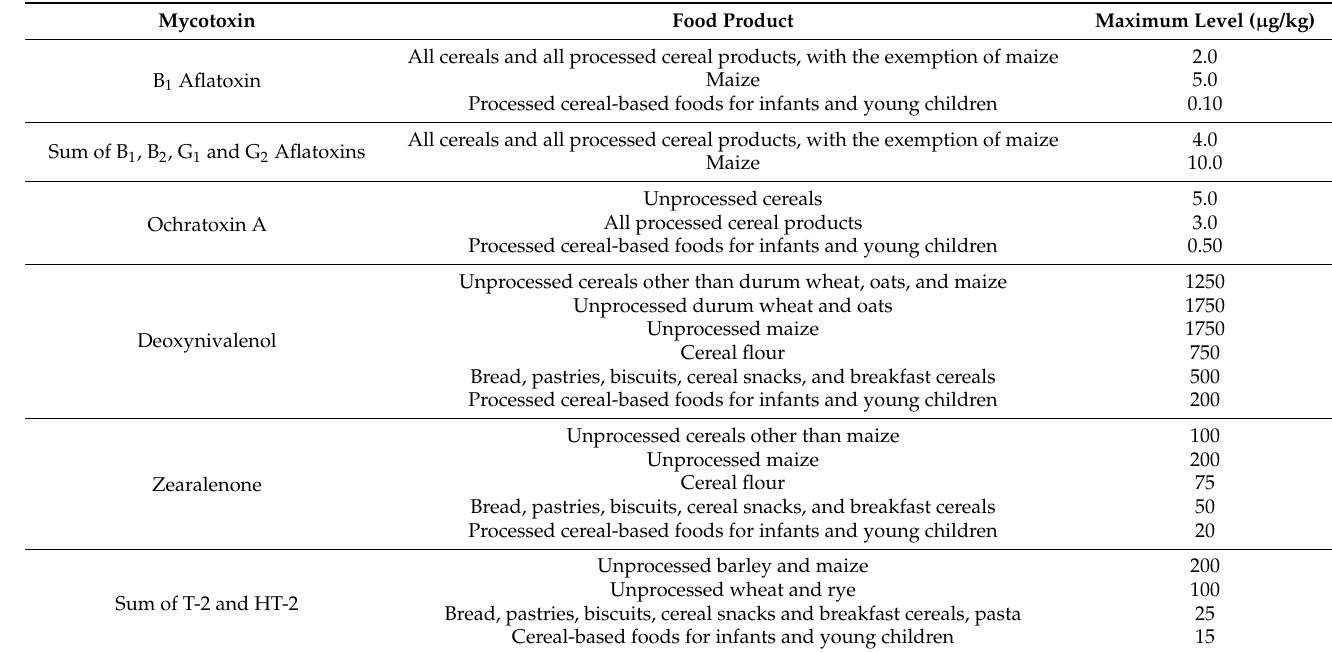
Table 2. Legislative limits for mycotoxins in cereals and cereal-based foodstuffs according to the EC Reg. 1881/2006 [38] and the Commission Recommendation 2013/165/EU